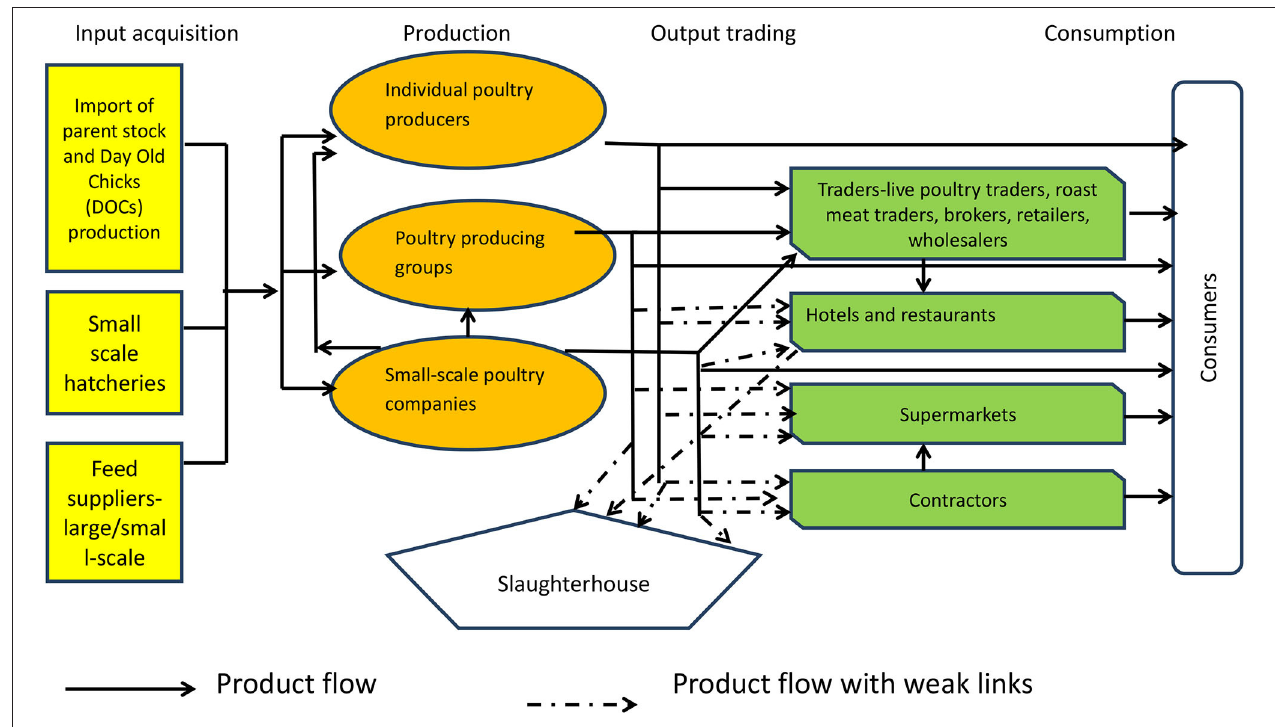
FIGURE 1 | Indigenous chicken value chain in Thika and Kisumu, 2016.